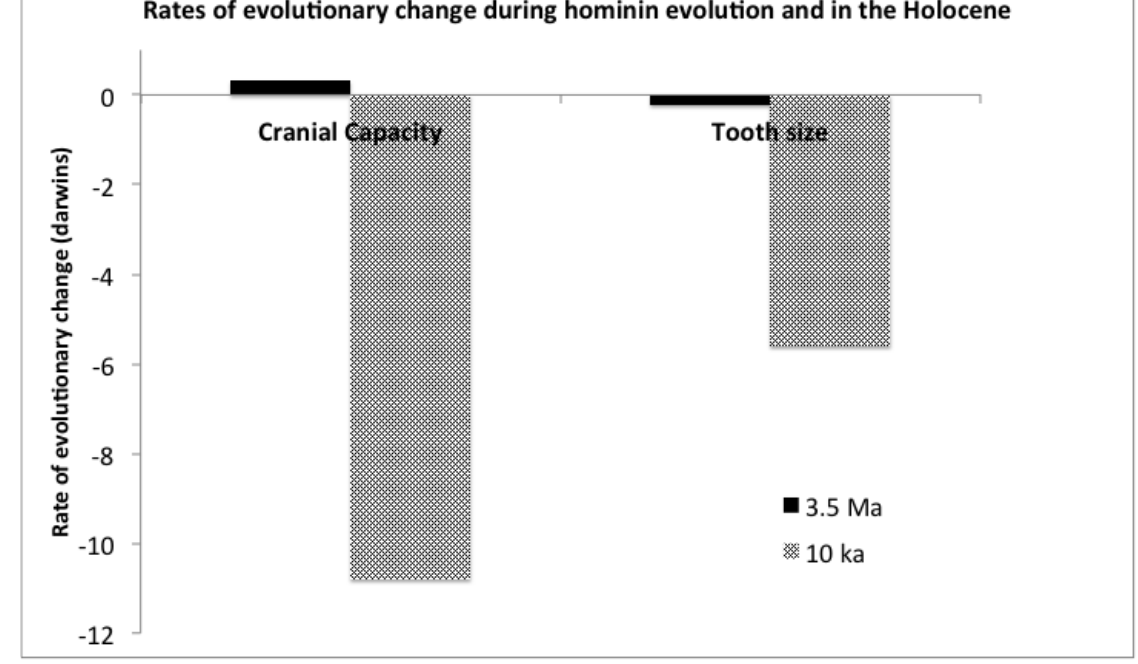
Figure 1. Rates of evolutionary change of cranial size and tooth size in the hominin evolution (the last 3.5 million years) and in the Holocene (the last 10 thousand years) [7]. Units are darwins: d = (lnX1 − lnX2)/t where X1 initial state of a character, X2 final state of a character, t—time. Note that rates in hominin evolution are just fractions of one darwin, while rates in the last 10 ka are several darwins. Rate of cranial capacity change in hominin evolution is positive, in the Holocene—negative. Tooth size rates for both periods are negative, they only differ in